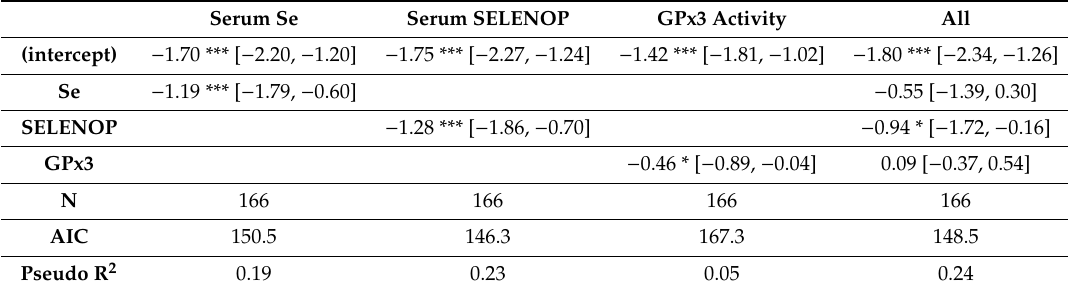
150.5 146.3 167.3